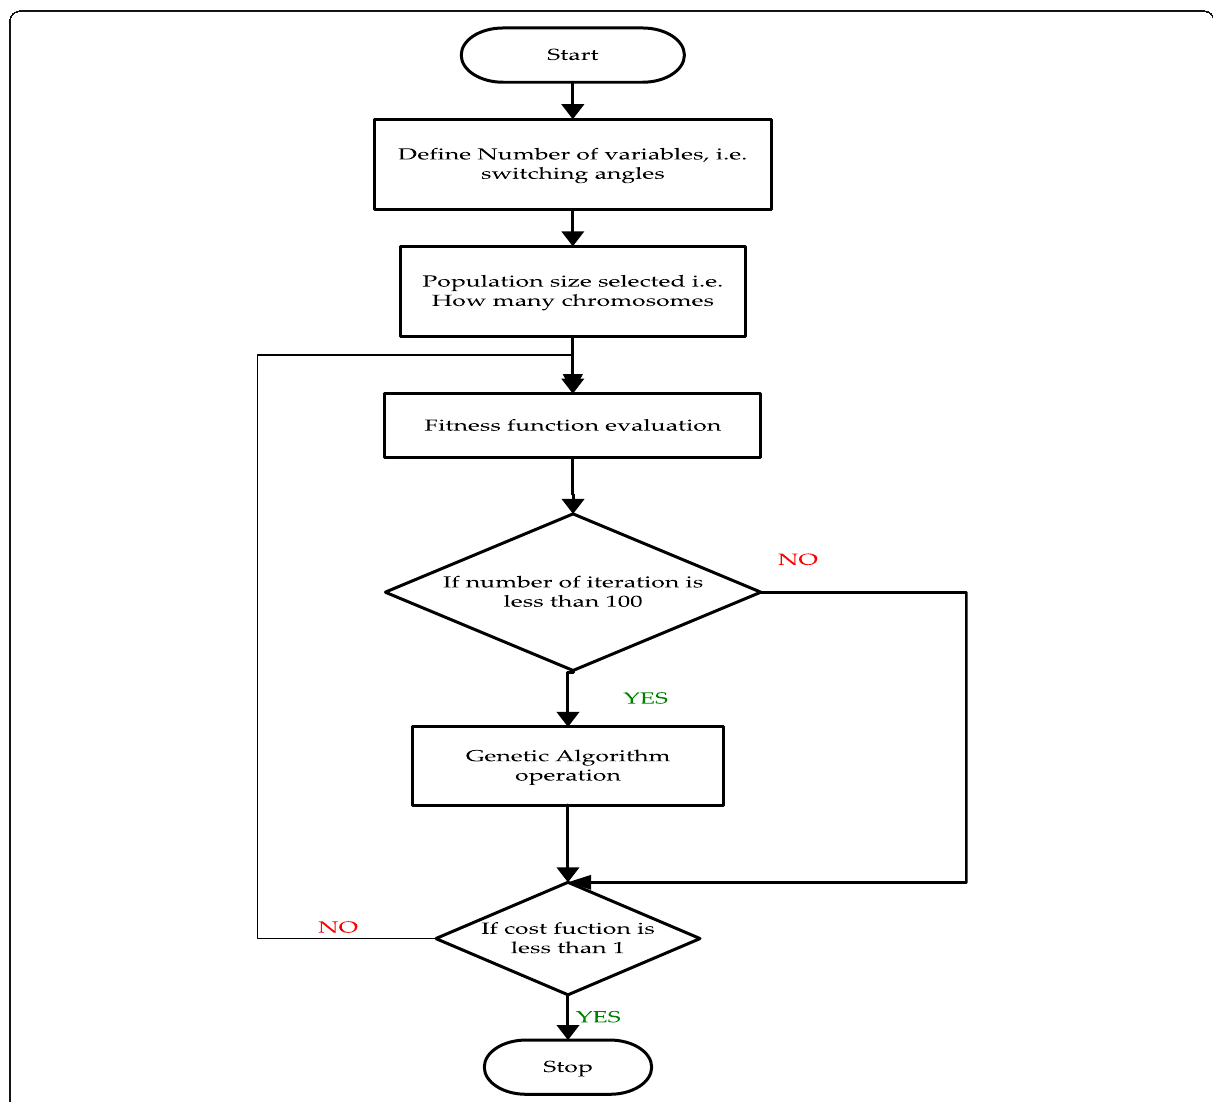
Fig. 2 Flowchart of the overall process of optimization technique, i.e., genetic